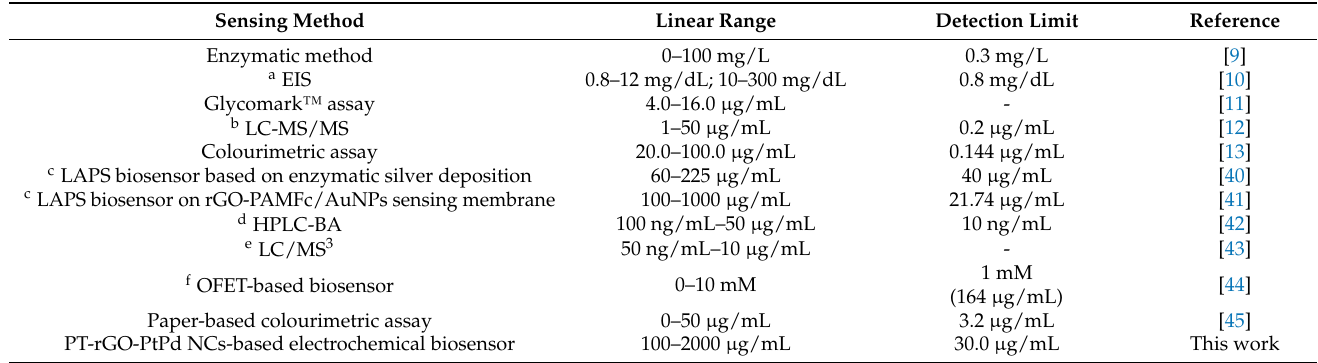
Table 1. A comparison between our proposed 1,5-AG electrochemical biosensor and other reported biosensors regarding sensing